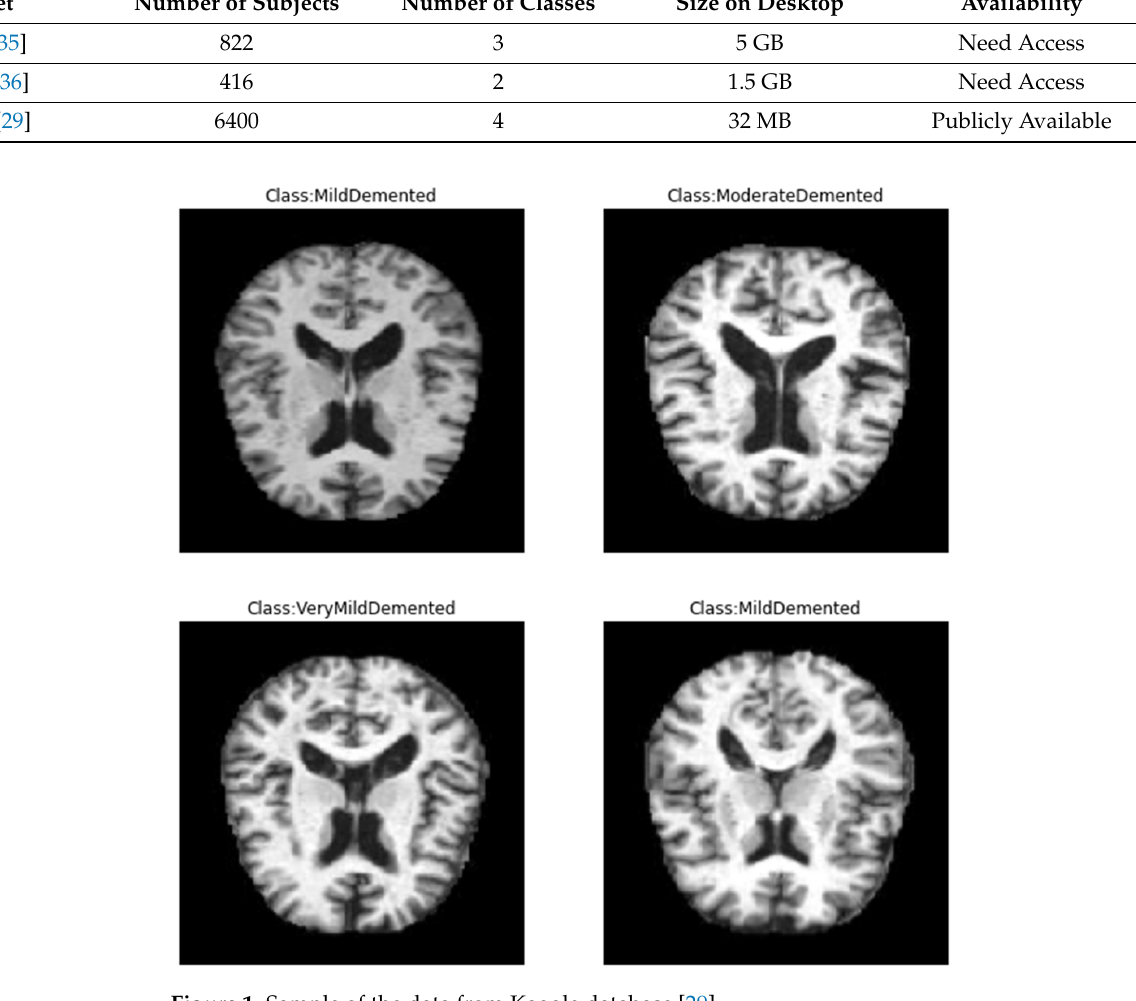
Figure 1. Sample of the data from Kaggle database [29].